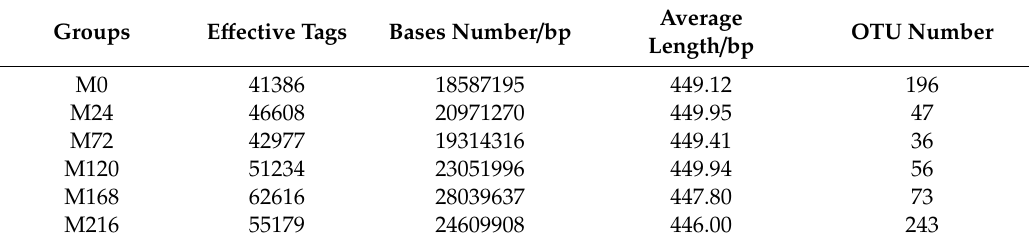
Table 3. The Number of E ff ective Tags, Base Numbers, OTUs and Average Length of the Genome of Spanish Mackerel at Di ff erent Time